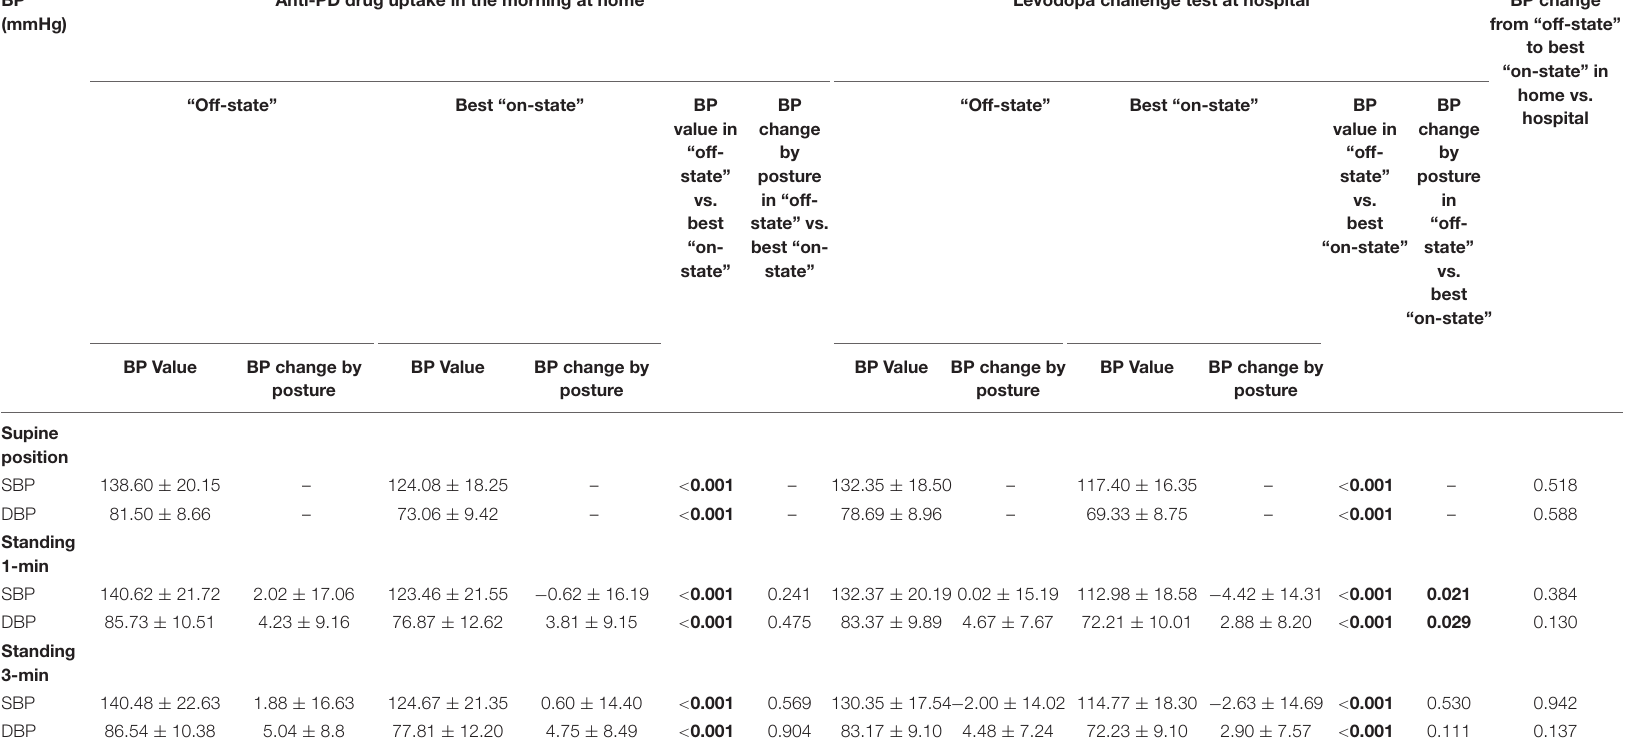
TABLE 4 | BP variation during anti-PD drug uptake at home and levodopa challenge test. BP (mmHg)